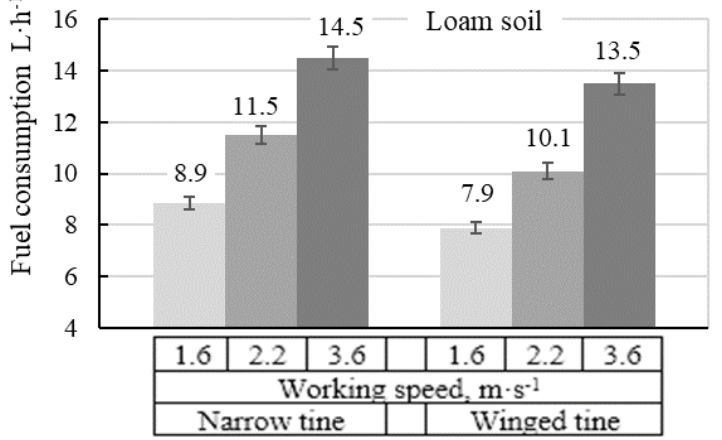
Figure 10. Dependence of hourly fuel consumption on speed and tine types on loam.